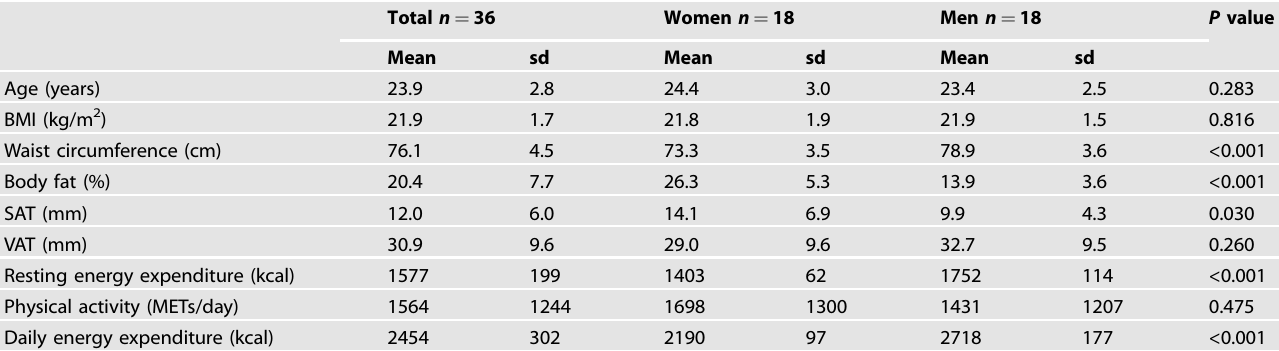
Table 2. Characteristics of the